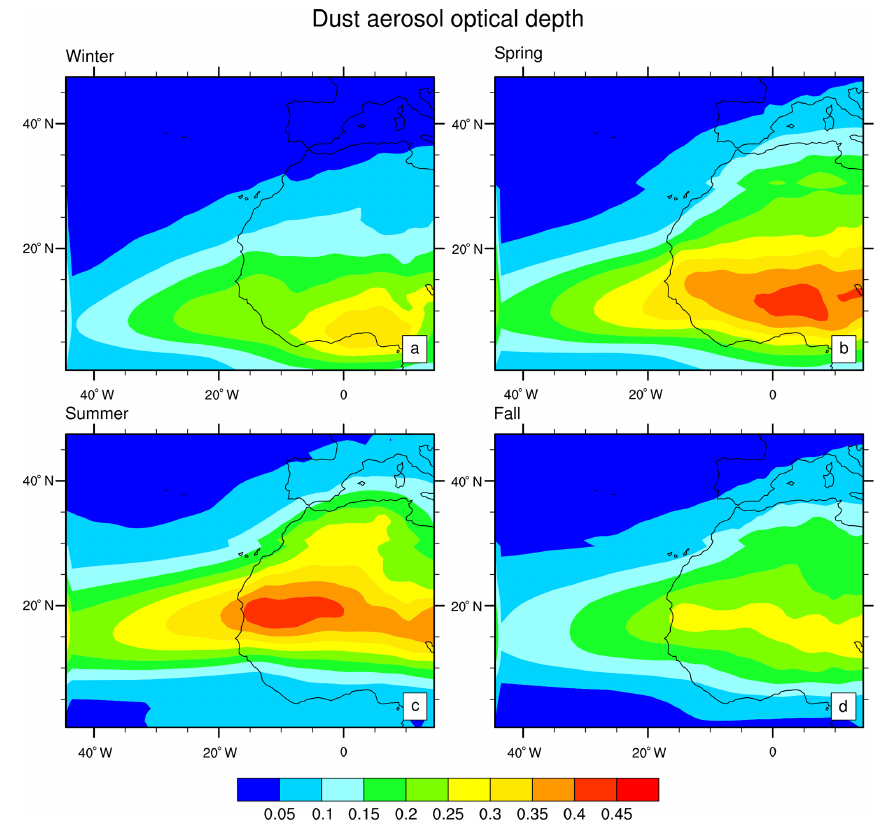
Figure 1. MACC dust aerosol optical depth (DAOD) from 2004 to 2012 in (a) winter, (b) spring, (c) summer, and (d)